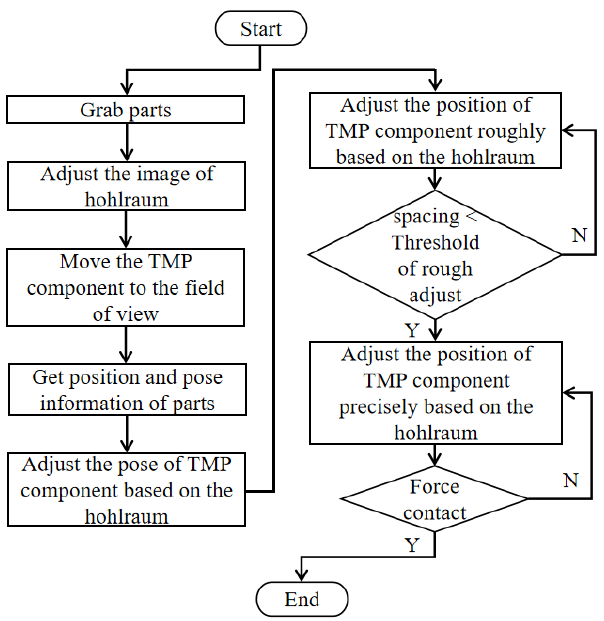
Figure 8. Flowchart of posture adjustment based on visual guidance.